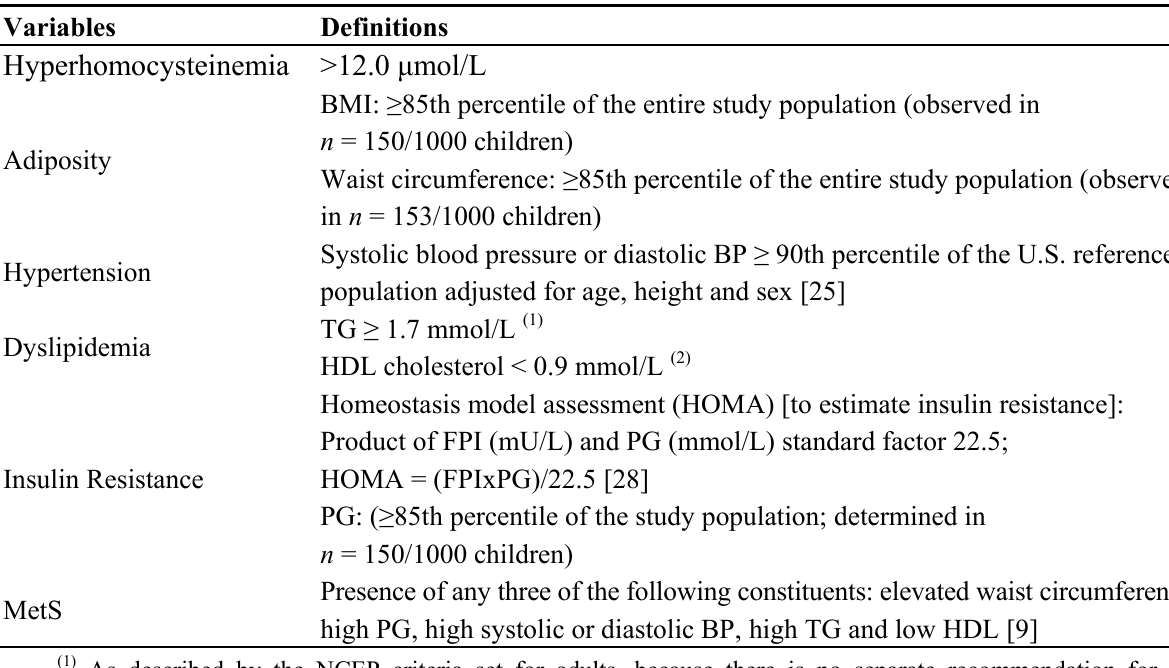
Table 1. Variable